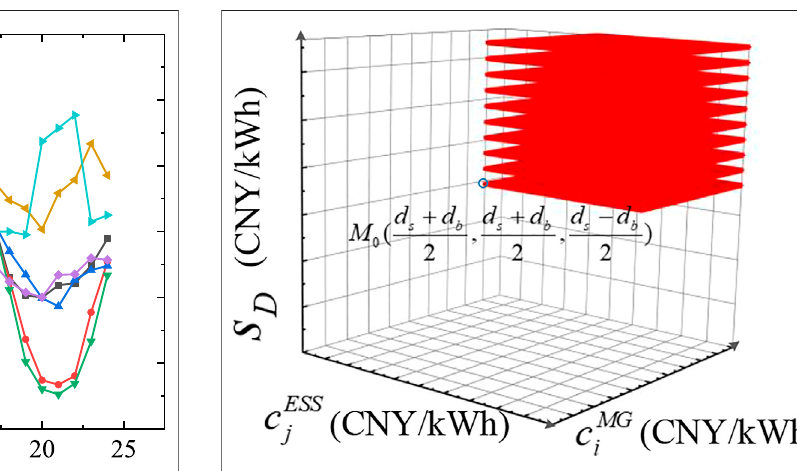
FIGURE 7 | Three-dimensional distribution of NE